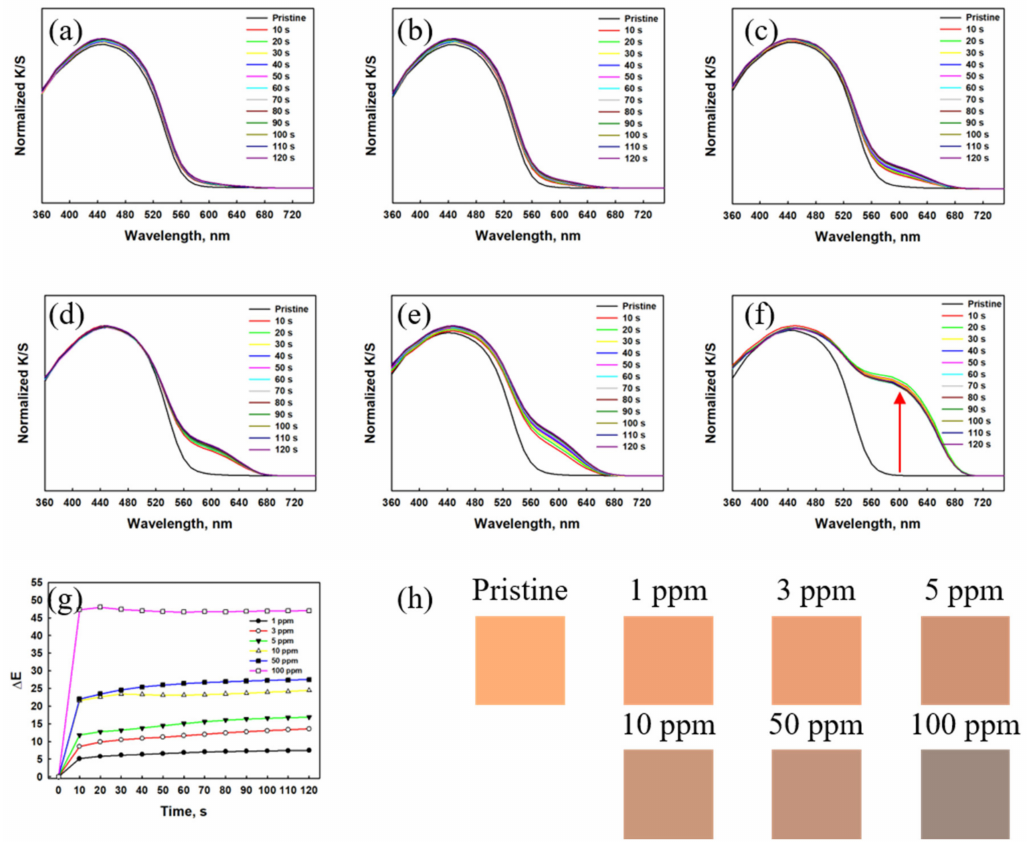
Figure 6. Color data for the textile sensor based on mixed dyes (Dye 3 / RhYK) after exposure to various concentrations of gaseous NH 3 : ( a – f ) Time-dependent K / S values upon exposure to 1, 3, 5, 10, 50, and 100 ppm NH 3 ; ( g ) Time-dependent color di ff erences; ( h ) Color